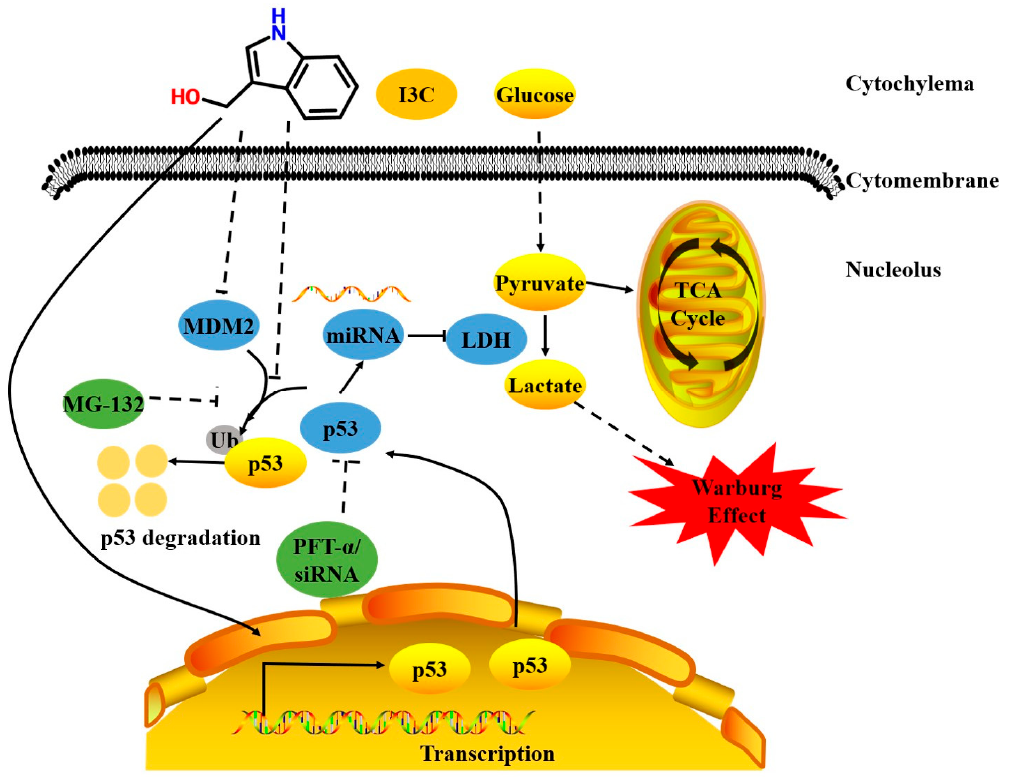
Figure 8. The schematic diagram of the action of I3C in liver cancer cells.